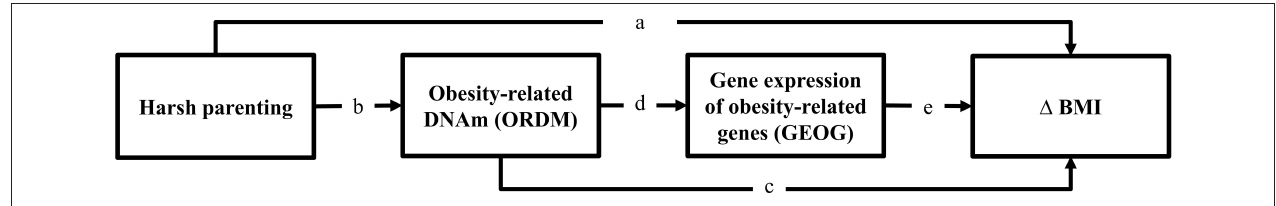
FIGURE 1 | Theoretical model showing hypothesized indirect pathways from harsh parenting in adolescence to change in BMI through obesity-related DNAm and gene expression of obesity-related genes. 1 = change in BMI from ages 10 (wave 1) to 29 (wave